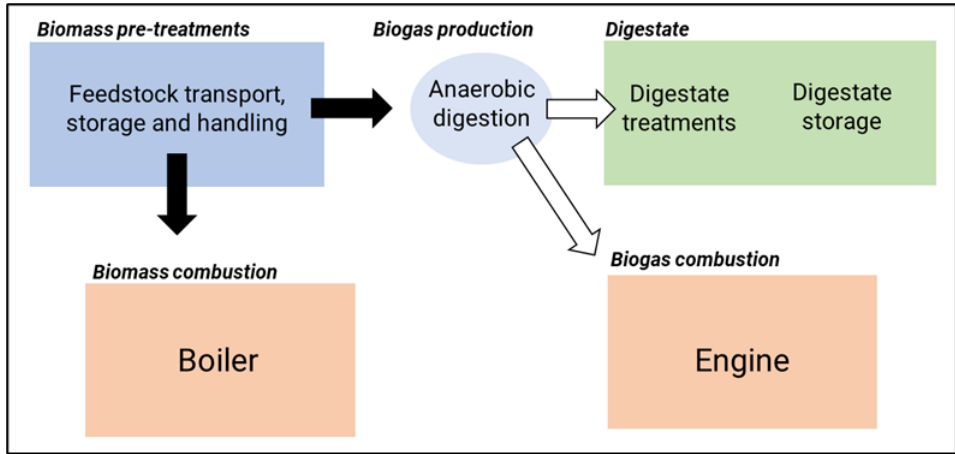
Figure 1. Overview of the main process and monitored activities within the included studies (mod- ified from [10]). fied from